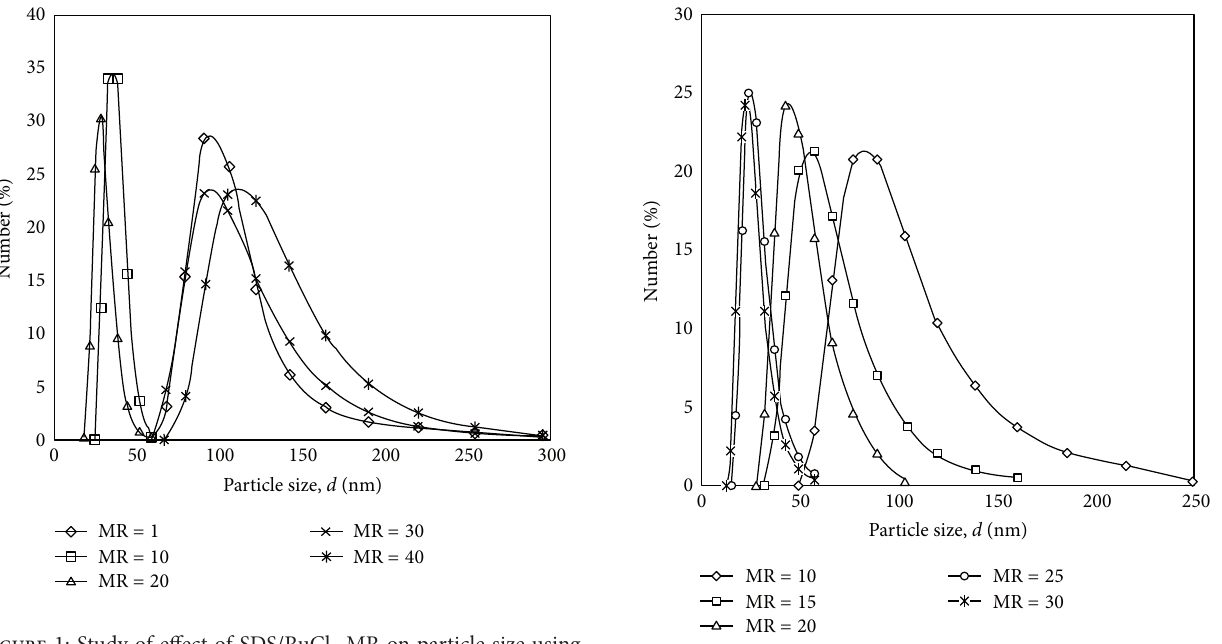
F 2: Study of effect of NaBH particle-size analyser.